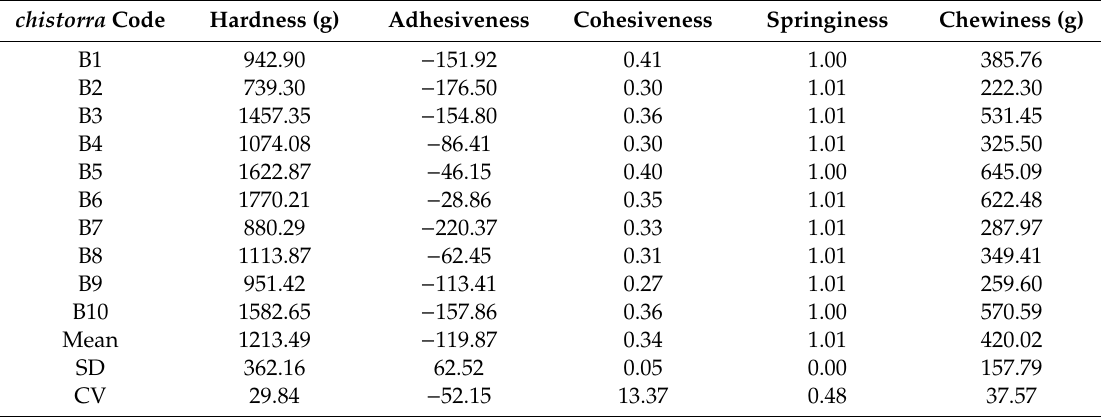
Table 7. Results of texture profile analysis (TPA) from the ten best scored chistorras (step 3).